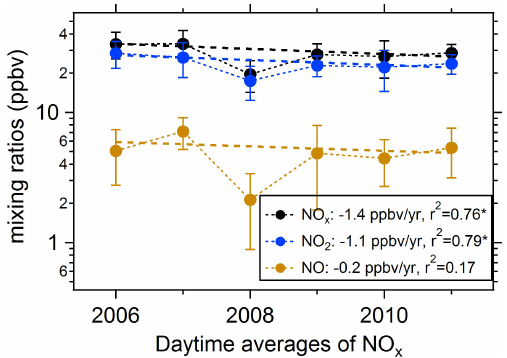
Figure 4. Variations in the daytime averages of NO x (black dots), NO 2 (blue dots), and NO (brown dots) in Beijing, August between 2006 and